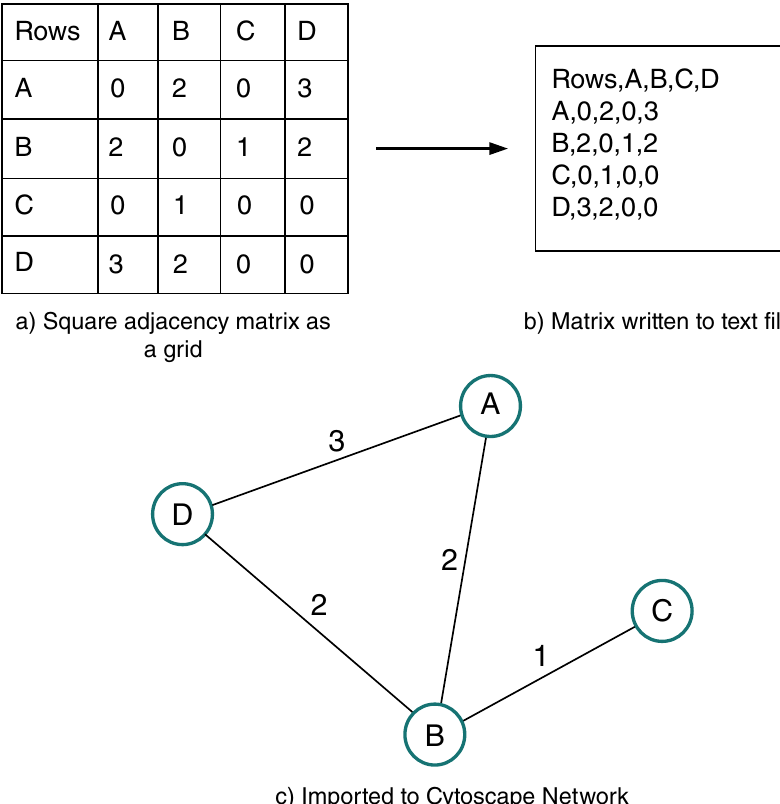
Figure 1. Converting a square adjacency matrix into an undirected network. ( a ) In Excel, Python, etc., the matrix is stored as a 2-dimensional array with optional labels. ( b ) The matrix is exported to a comma delimited file. ( c ) Importing the undirected matrix into Cytoscape with aMatReader, edges are defined by nonzero values within the upper